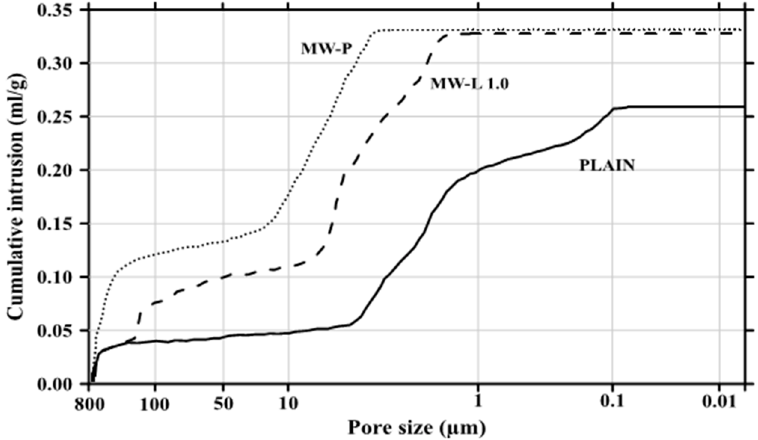
Figure 8. Cumulative pore volume.